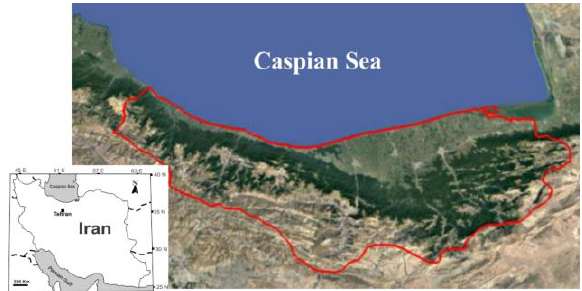
Figure 1 . Google earth map of the southern shores of the Caspian Sea; red line shows the province boarder of